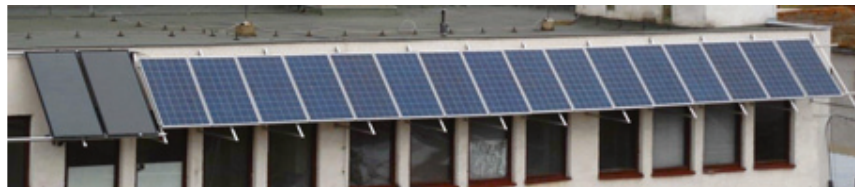
Figure 12: View on solar photothermal and photovoltaic collectors installed for experimentally tested system.